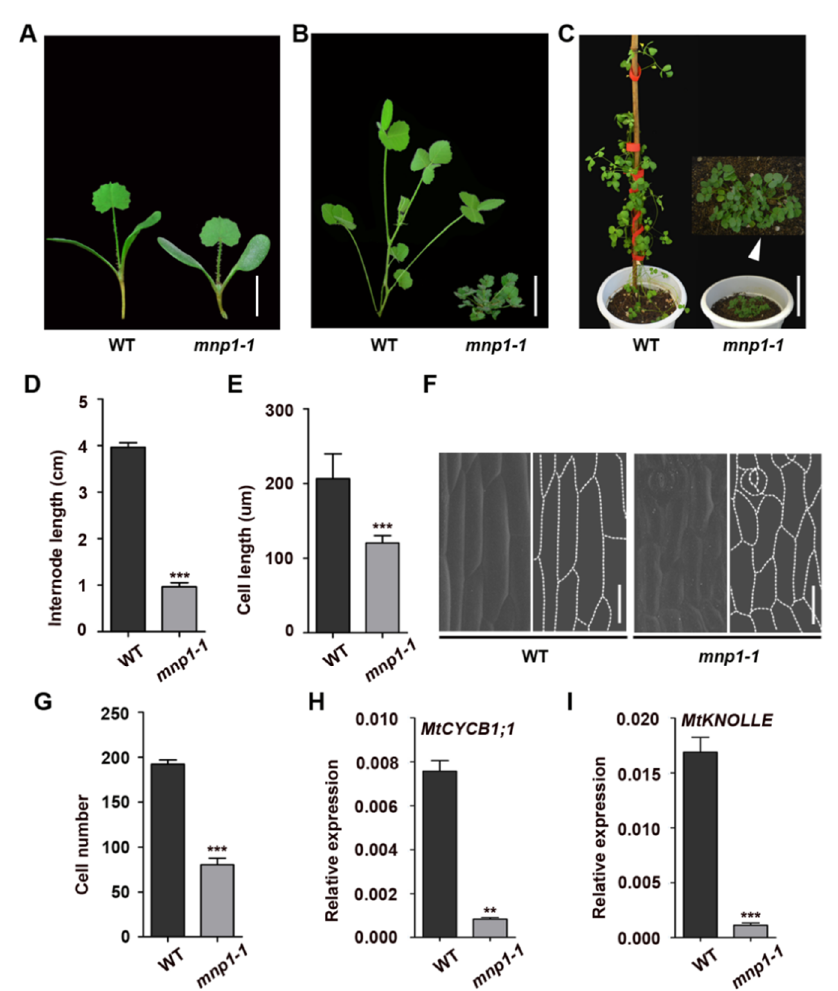
Figure 1. Phenotypic characterization of mnp1-1 mutant. ( A – C ) Morphologies of wild type (WT) and mnp1-1 mutant at different developmental stages. ( A ) Ten days after sowing. Scale bar = 0.75 cm. ( B ) Six weeks after sowing. Scale bar = 2 cm. ( C ) The reproductive stage of plants. Scale bar = 6.5 cm. ( D ) The length of the third internode beneath the shoot apex. Values are means ± SD ( n = 20 internodes). Two-sample t -test, *** p < 0.001. ( E ) The length of epidermal cells of the third internode beneath the shoot apex. Values are means ± SD ( n = 20 cells from three biological replicates). Two-sample t -test, *** p < 0.001. ( F ) Scanning electron microscope images and cell outlines of a representative third internode beneath the shoot apex. Scale bar = 50 um. ( G ) Number of epidermal cells in the third internode beneath the shoot apex. The cell number was calculated from the ratio of the average internode length ( D ) to the average cell length ( E ). Error bars represent the standard deviation of the cell number of 20 independent internodes. Two-sample t -test, *** p < 0.001. ( H ) Expression analysis of cell division marker gene MtCYCB1;1. Values are means ± SD . Two-sample t -test, ** p < 0.01. ( I ) Expression analysis of cell division marker gene MtKNOLLE. Values are means ± SD . Two-sample t -test, *** p < 0.001.